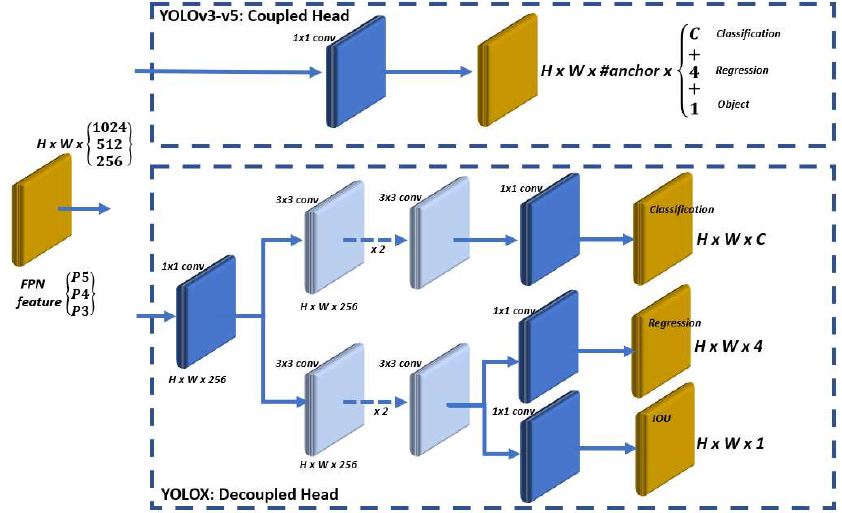
Figure A1. Coupled head in YOLOv3 and decoupled head in